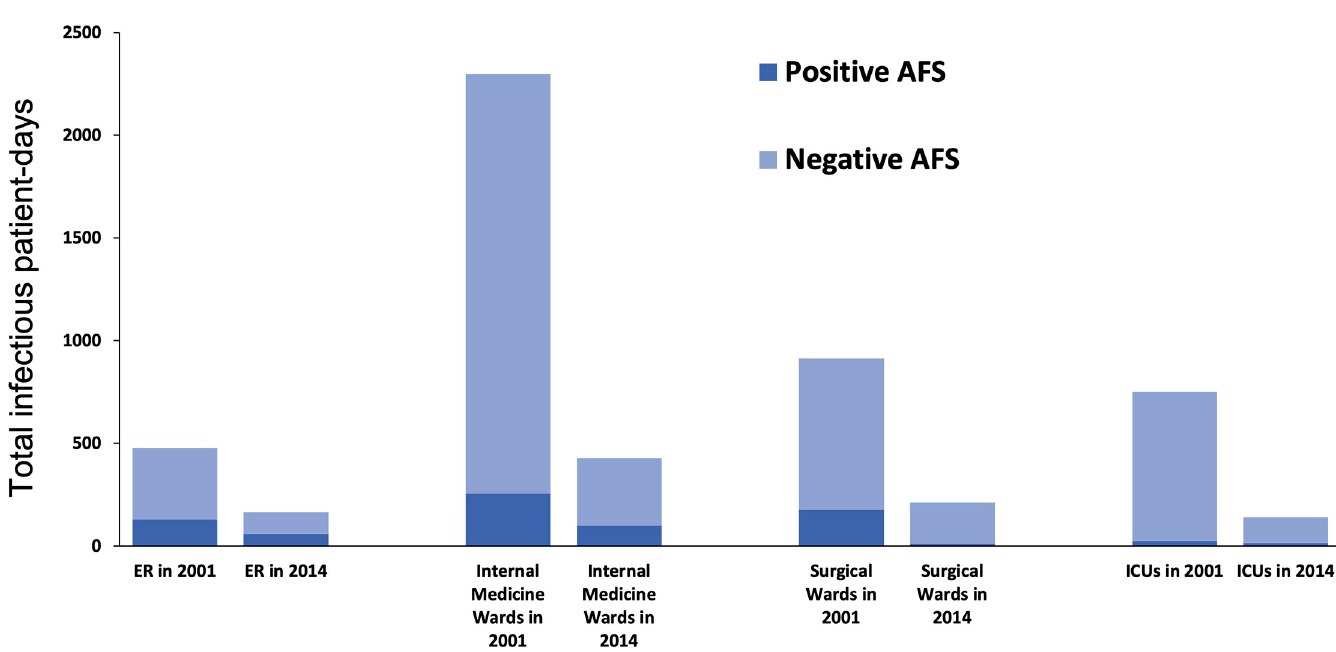
Fig 3. Total non-isolated infectious patient-days from hospitalized patients with culture-confirmed tuberculosis, 2001 vs. 2014. Abbreviations: AFS, acid-fast smear; ED, emergency department; ICUs, intensive care units. Internal medicine wards: general medicine, cardiovascular medicine, pulmonary medicine, endocrinology, gastro-enterology, hematology, infectious diseases, nephrology, oncology, and paediatrics. Surgical wards: cardiovascular surgery, neurosurgery, otolaryngology, general surgery, chest surgery, proctology, ophthalmology, orthopaedics, plastic surgery, and urology.